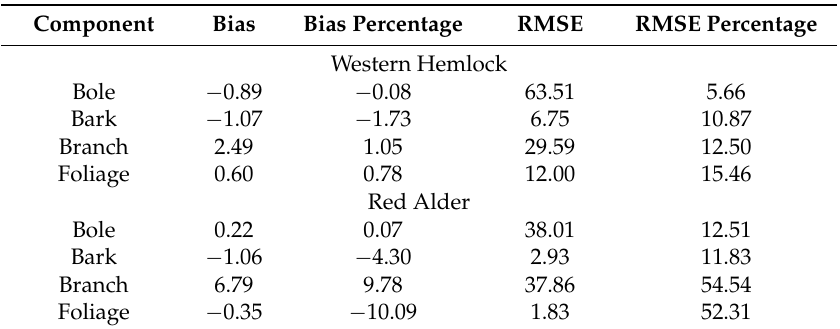
Table 8. Evaluation statistics (Bias, bias percent, RMSE, and RMSE percent) in component biomass estimation in Western hemlock and red alder trees using the Dirichlet regression.